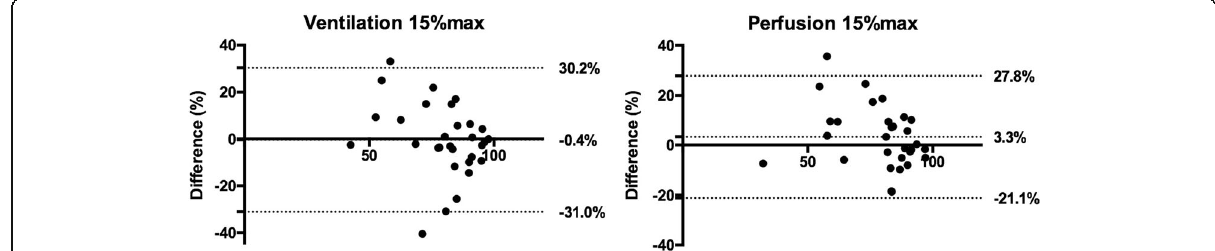
Fig. 3 Bland-Altman plot of automatic volumes using the 15%max threshold and the manual contours. The bias and the limits of agreement are displayed in each graphic